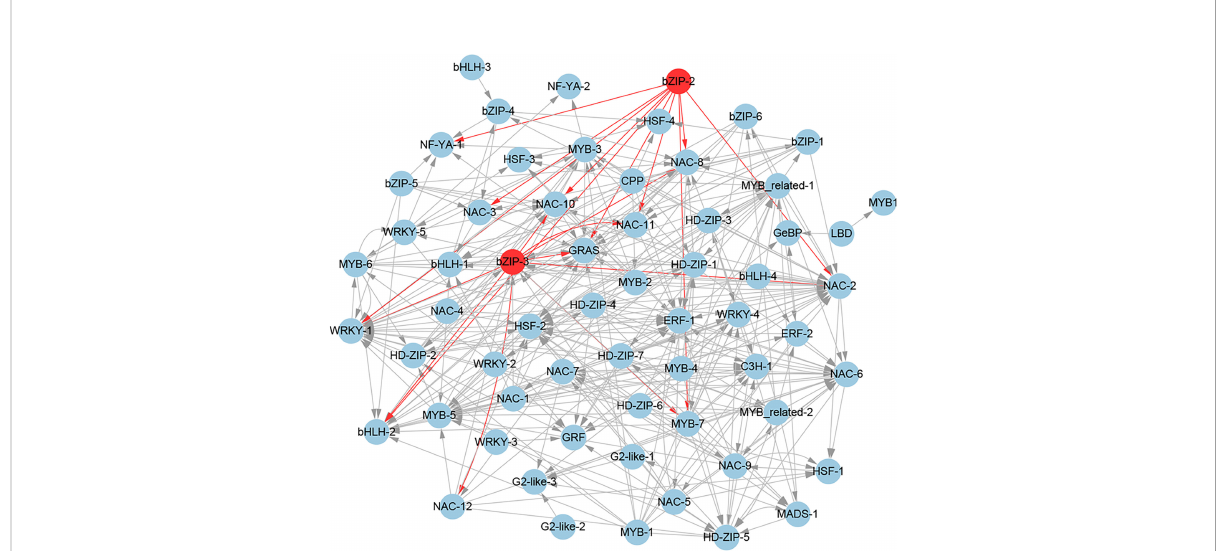
FIGURE 9 The regulatory network of potential drought-resistant TFs in XZSN. TFs (bZIP-2 and bZIP-3), labeled by a red circle, represents the homologs of key TFs (ABFs) of the abscisic acid (ABA) signal pathway in Arabidopsis .